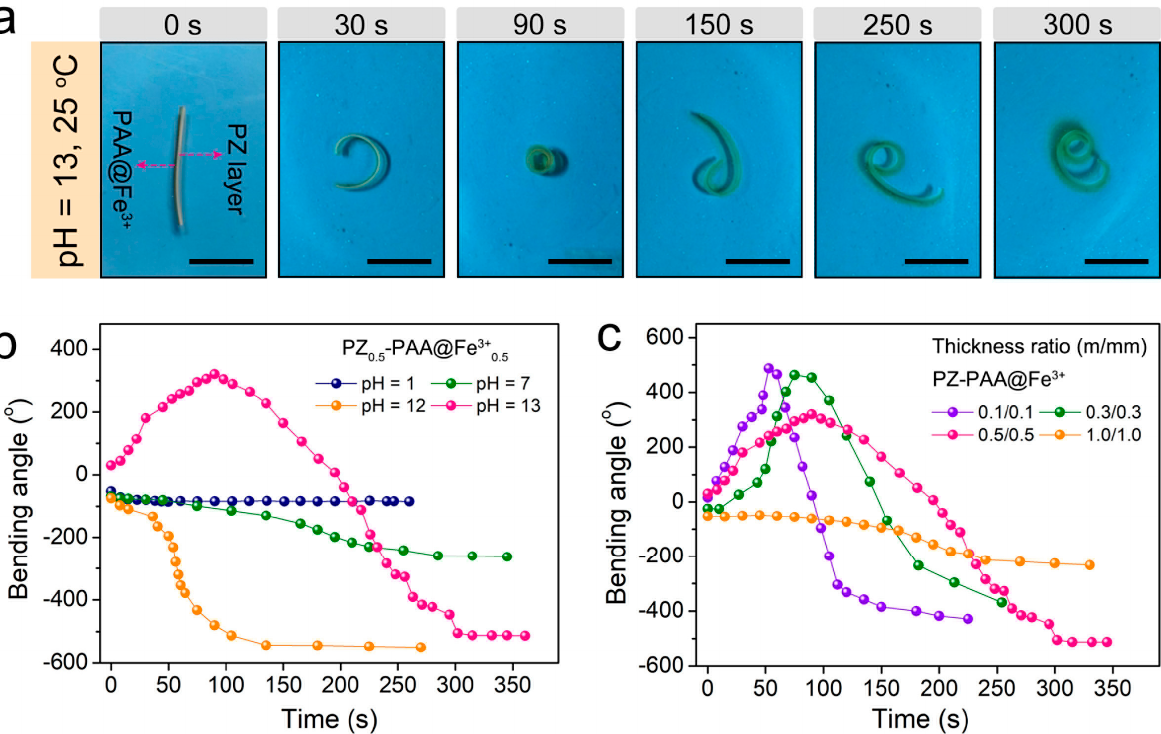
Figure 3. ( a ) Optical photos of bending process of PZ-PAA@Fe 3+ bi-layer hydrogel strip in pH = 13 at 25 °C. Bending kinetics of bi-layer hydrogel strips affected by ( b ) different pH and ( c ) different thickness ratios of PZ-PAA@Fe 3+ . All scale bars are 10 mm.